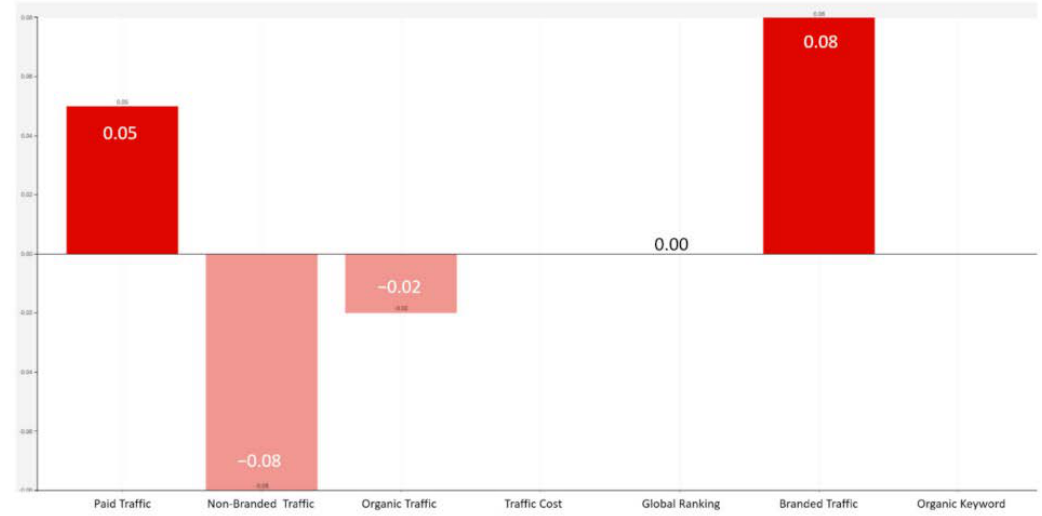
Figure 6. Scenario 2 results (COVID-19 cases at 0.9, paid keywords at